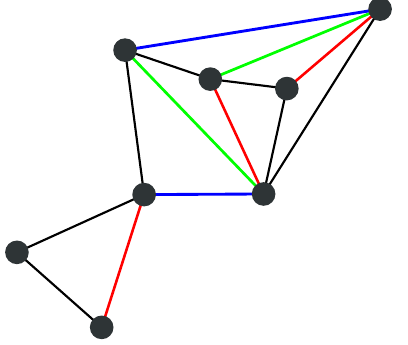
FIG. 2. Example network illustrating how iterated triadic closures are implemented in the model. The initial network (black edges) receives the first generation of triadic closures (red edges). The second generation (green edges) can only close triads involving at least one edge of the first generation (red). The third generation (blue edges), in turn, can only close triads involving at least one edge belonging to the second generation